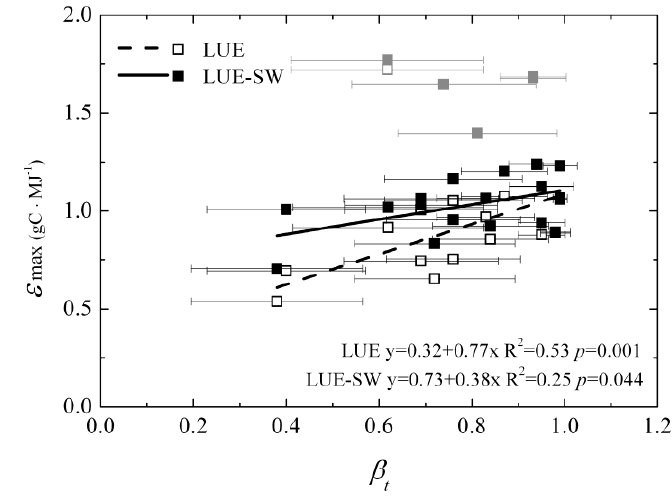
Figure 5. The annually averaged soil water factor ( β use efficiency ( ε ) used in the LUE and LUE-SW, excluding four sites with ε max than 1.3 gC∙MJ −1 (gray symbols). The bar represents ±0.5 standard deviation of β